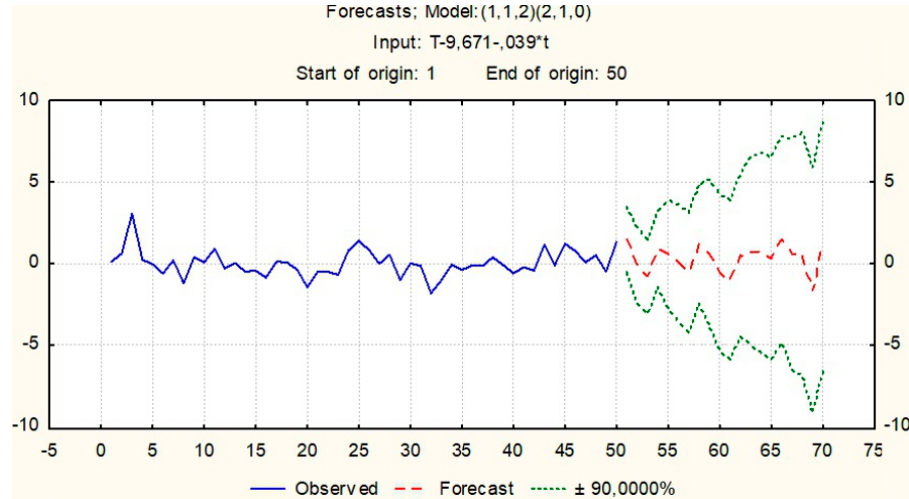
Figure 9. Forecast of mean annual water temperature for station Oder-Brzeg for the selected ARIMA model (blue–observed values; red–forecasted values; green–±90% confidence interval).